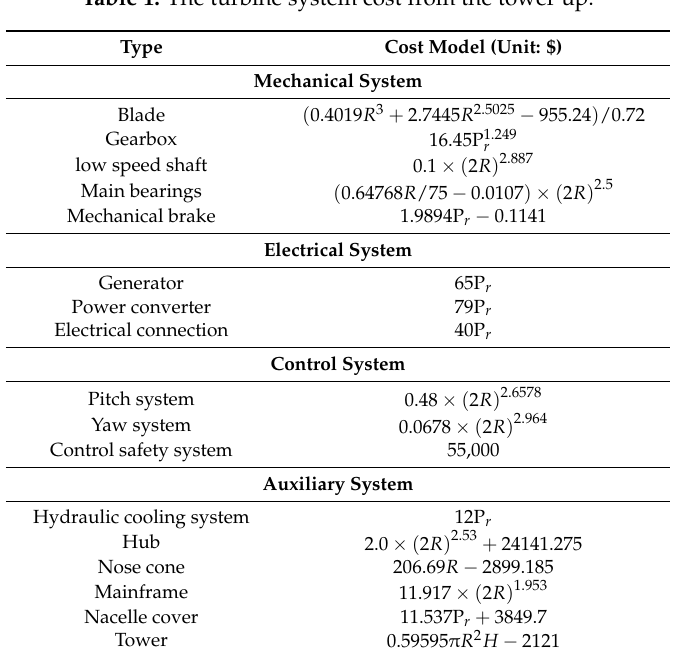
Table 1. The turbine system cost from the tower up.